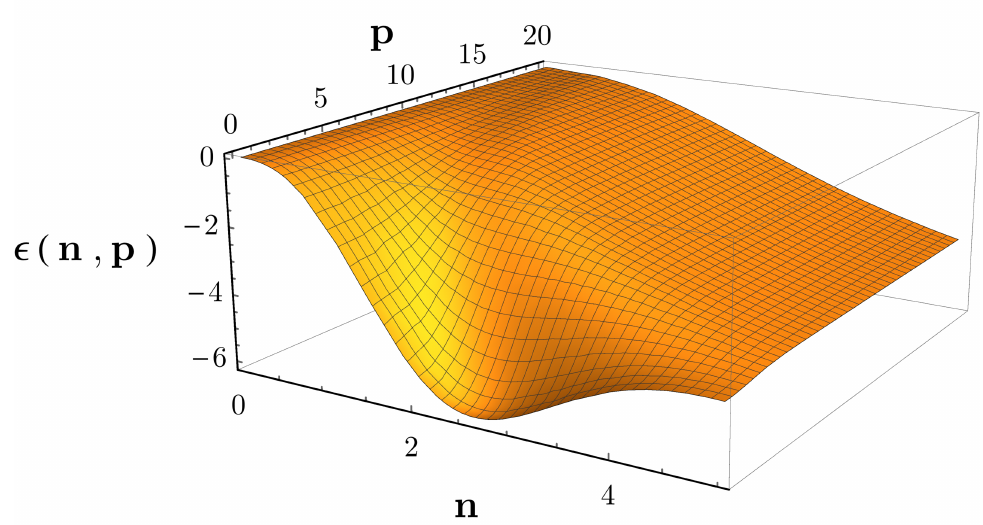
Figure 8 . Energy spectrum ε ( n , p ) of large neutral excitations plotted as a function of n and p ( ν = 1 ).